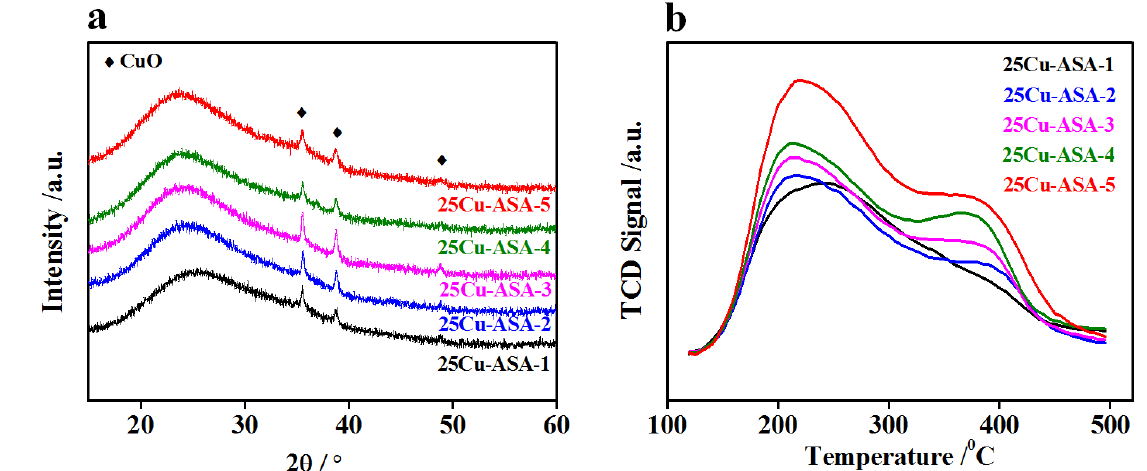
Figure 6. The XRD ( a ) and NH 3 -TPD ( b ) patterns of the calcined 25Cu–ASA- y catalysts. To estimate the acidity of the 25Cu–ASA- y catalysts, NH 3 -TPD experiments were per- formed, and the results are shown in Figure 6b. Irrespective of the Si/Al ratios of the 25Cu– ASA- y samples, the pre-adsorbed NH 3 molecules were overwhelmingly desorbed at tem-